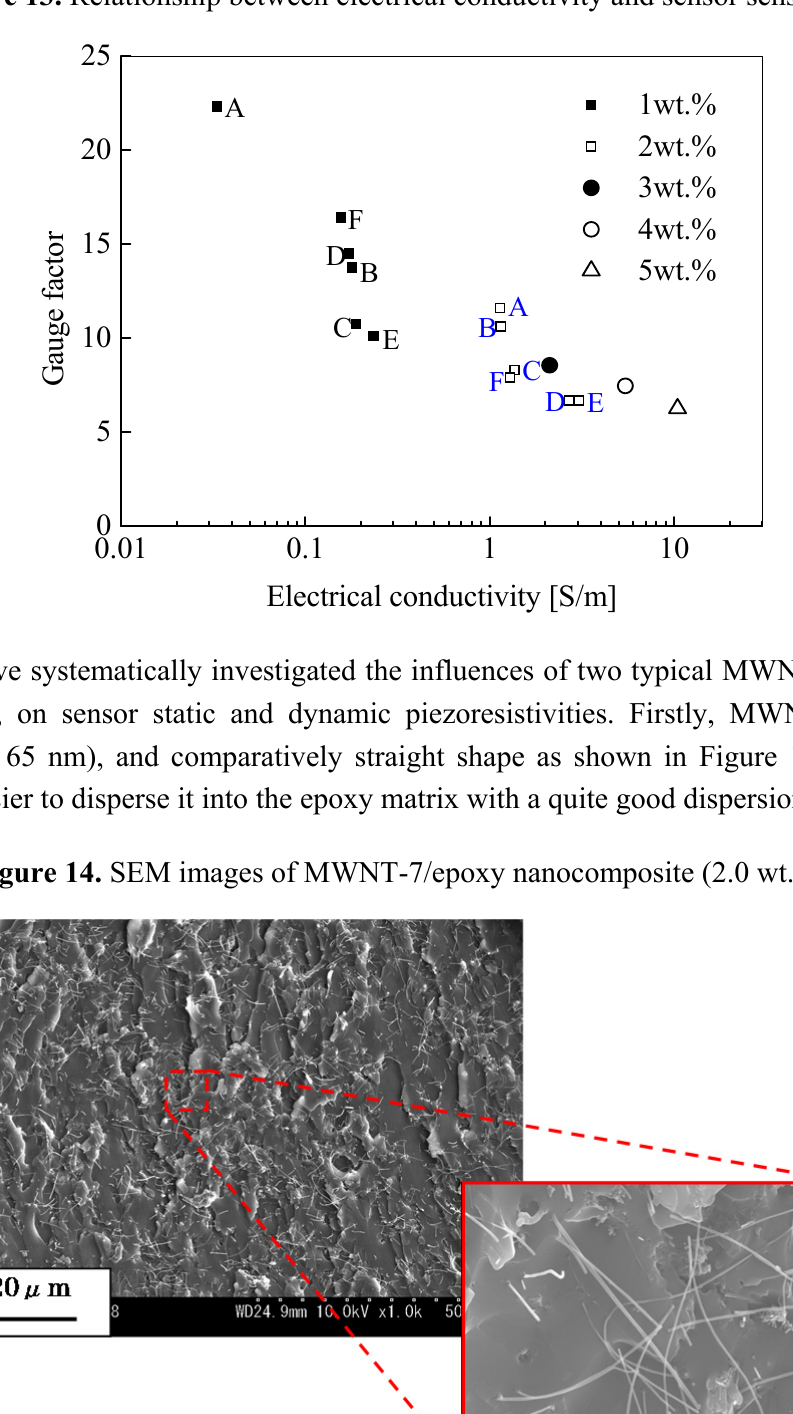
Figure 13. Relationship between electrical conductivity and sensor sensitivity.